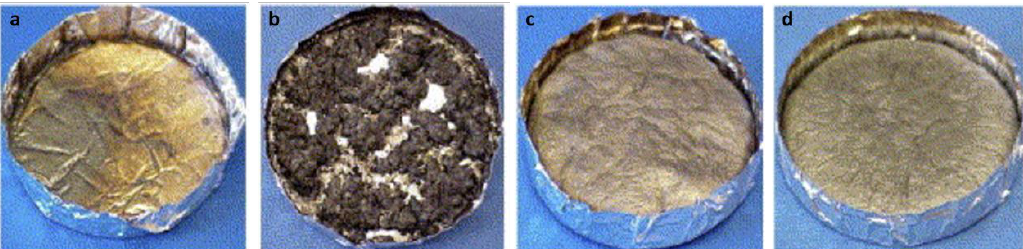
Figure 18. Effects of nanotube content on residues of PMMA/SWNT nanocomposites (note: The residues were obtained after gasification tests in a nitrogen atmosphere at an external radiant flux of 50 kW m − 2 ): ( a ) PMMA, ( b ) PMMA/SWNTs (0.2%), ( c ) PMMA/SWNTs (0.5%), and ( d ) PMMA/SWNTs (1%). Reprinted with permission from Ref. [161]. Copyright 2005, Elsevier. Table 6. Mass fractions of residues normalized by the original sample mass collected after gasifica- tion tests. Reprinted with permission from Ref. [161]. Copyright 2005, Elsevier.